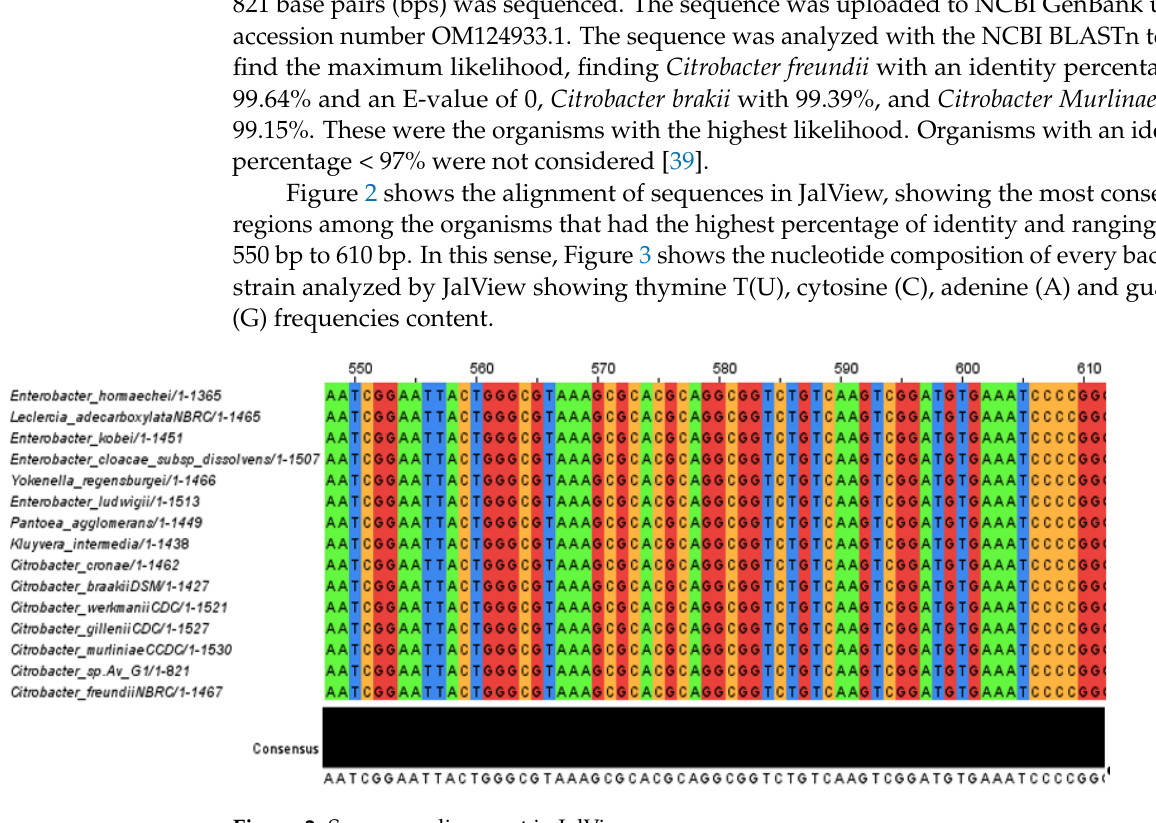
Figure 2. Sequence alignment in JalView.